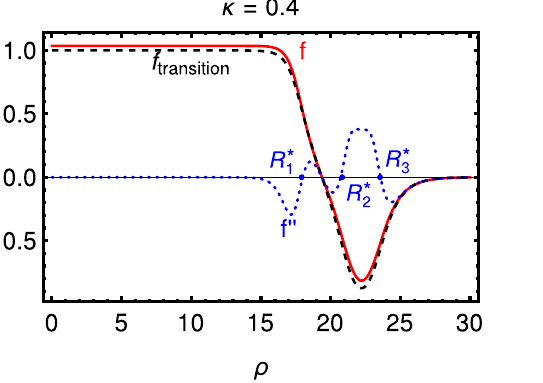
Fig. 3 Numerical profiles f (ρ) in red for κ = 0 . 4 (left) and κ = 0 . 1 (right). Also shown in dashed black is the analytic approximation f transition from Eq. (22); the latter depends on the three radii R ∗